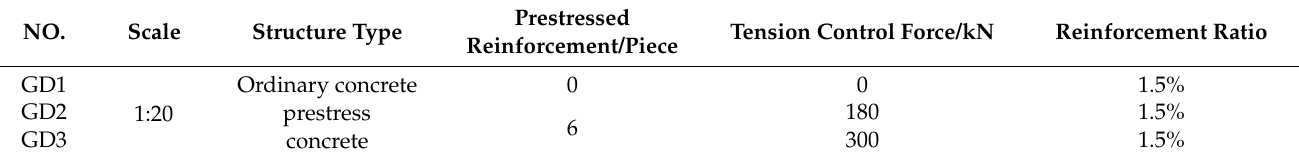
Table 1. Details of